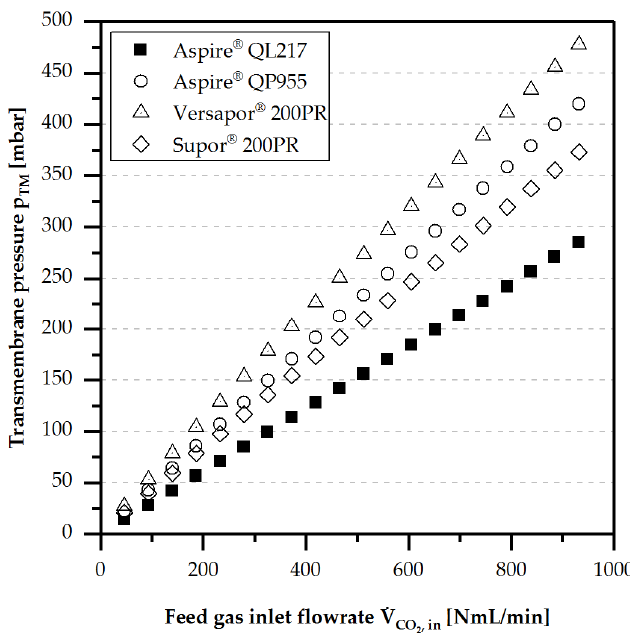
. Figure 7. Transmembrane pressure at different V CO2 for all membranes at ϑ = 20 ◦ C and calculated Figure 7. Transmembrane pressure at different V̇  for all membranes at ϑ = 20 °C and calculated average permeabilities for all membranes at ϑ = 20 ◦ C. average permeabilities for all membranes at ϑ = 20 °C .